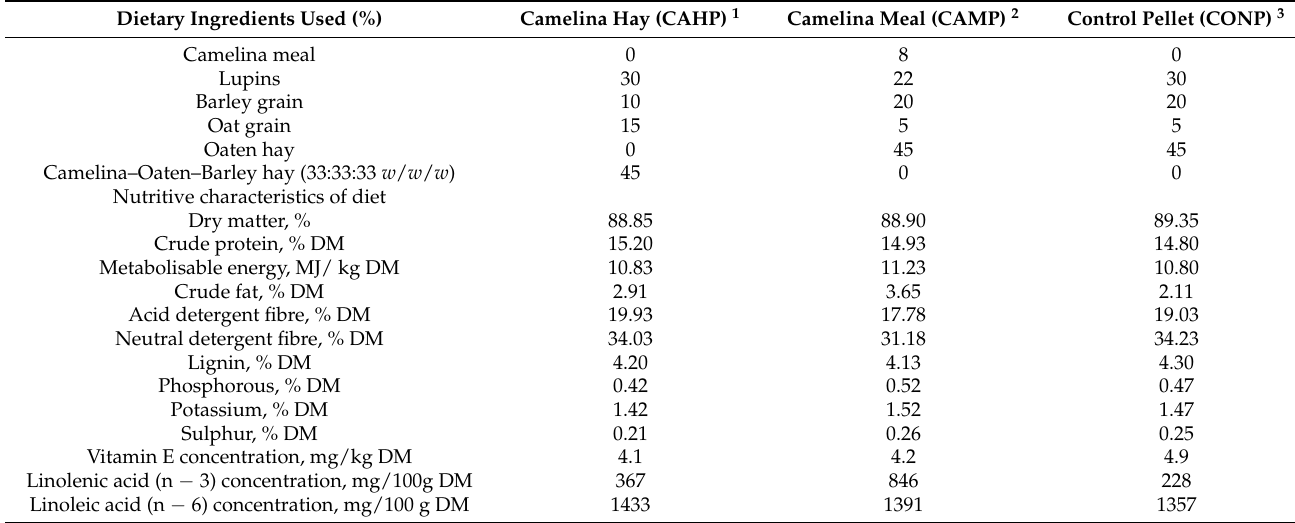
Table 1. Dietary ingredients, nutritive characteristics, vitamin E, α -linolenic acid, and linoleic acid concentrations of pelleted diets fed to Maternal Composite lambs and Merino yearlings. Dietary Ingredients Used